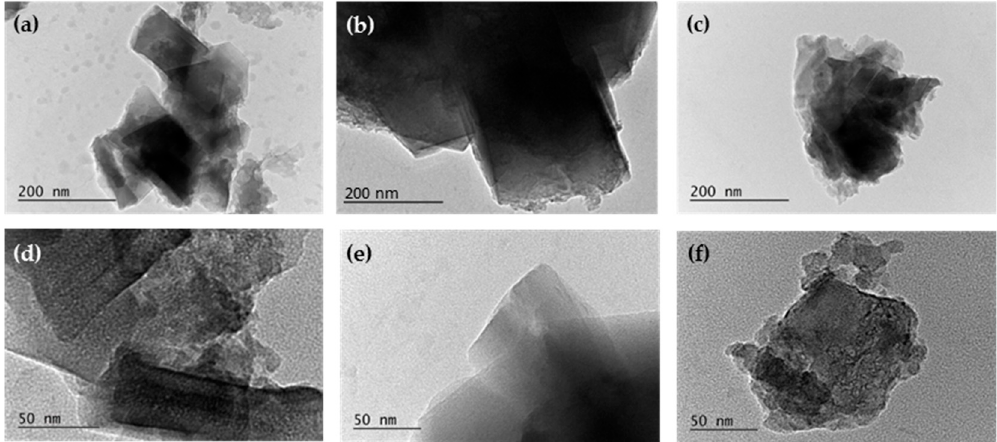
Figure 4. SEM micrographs of powders from initial Na-X 0 zeolites ( a , e ) and zeolites after milling for 60 ( b , f ), 120 ( c , g ), and 540 ( d , h ) seconds at magnifications of 5000 × ( a – d ) and 20,000 × ( e – h ).